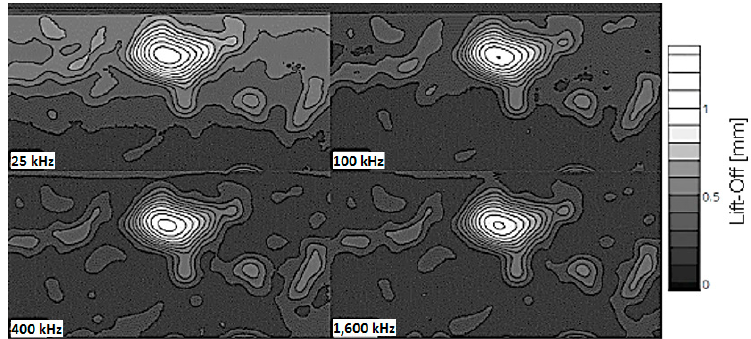
Figure 4. Four frequency comparison.